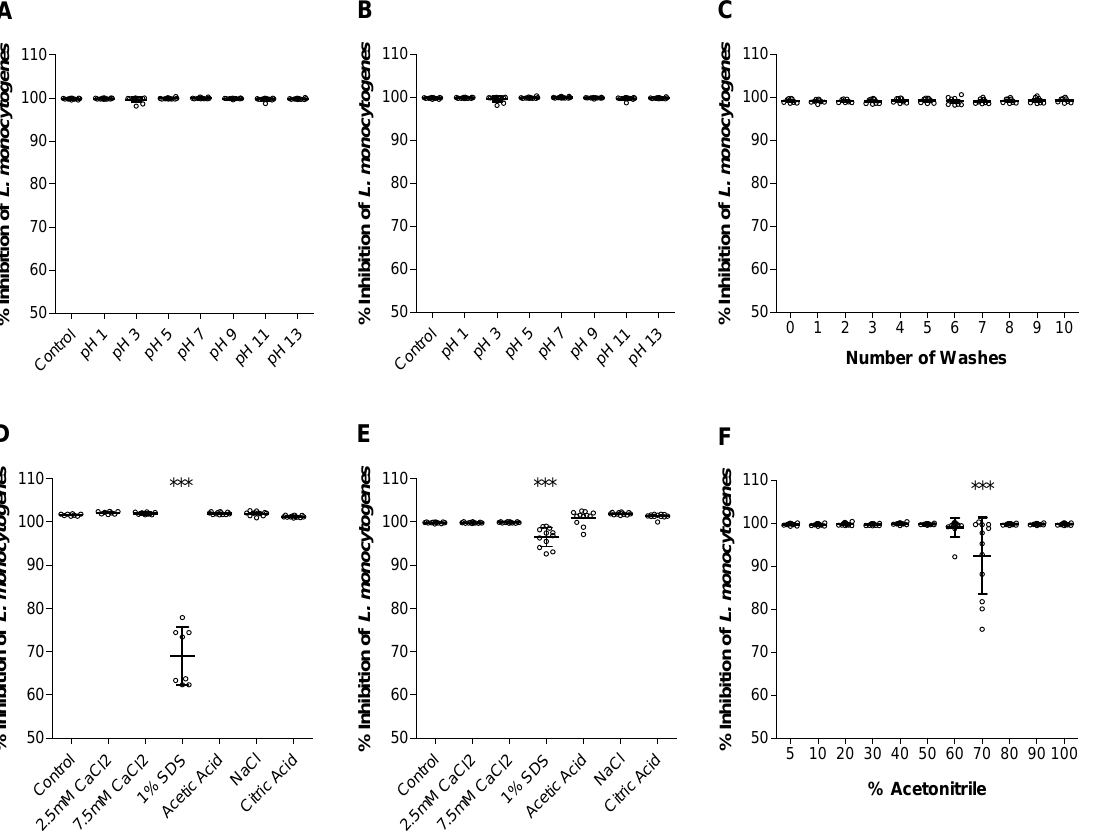
Figure 5. Antimicrobial activity, expressed in percentage metabolism inhibition against L. monocyto- genes , of Trc mix ( A , D ) adsorbed and ( B , E ) desorbed in the presence of pH ranges, salts, 1% SDS, 5% m / v acetic acid, 5 mM NaCl, and 3% m / v citric acid. Antimicrobial activity of Trcs-treated cellulose exposed to ( C ) multiple water washes and ( F ) treatment with ranges of percentage ( v / v ) acetonitrile. Data represents the mean and SD of three biological and four technical repeats. Statistical analysis between untreated as control and the other conditions were determined with One-way ANOVA and Bonferroni’s Multiple comparison post -test; *** p < 0.001.